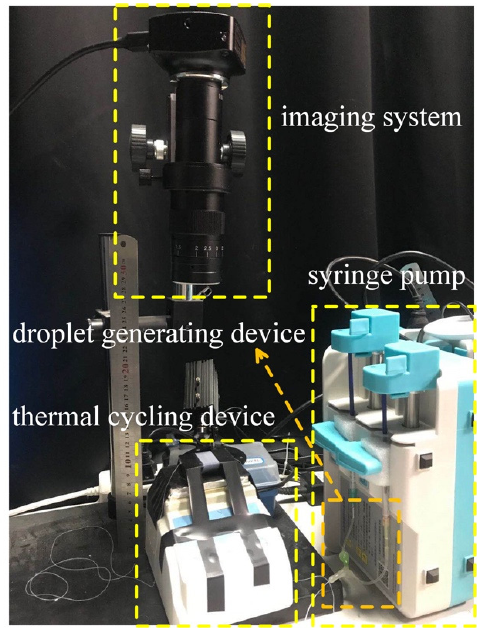
Figure 1. Miniaturized continuous-flow digital polymerase chain reaction (dPCR) system.